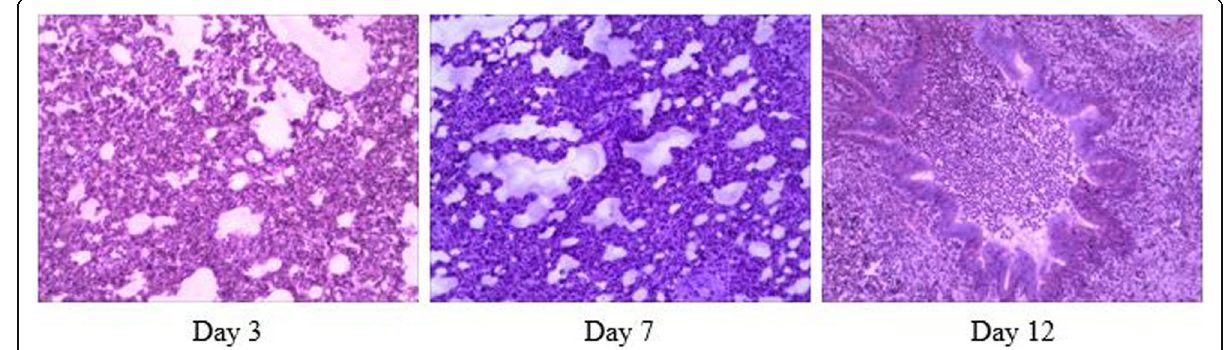
Fig. 4 Lung histopathological observation of positive